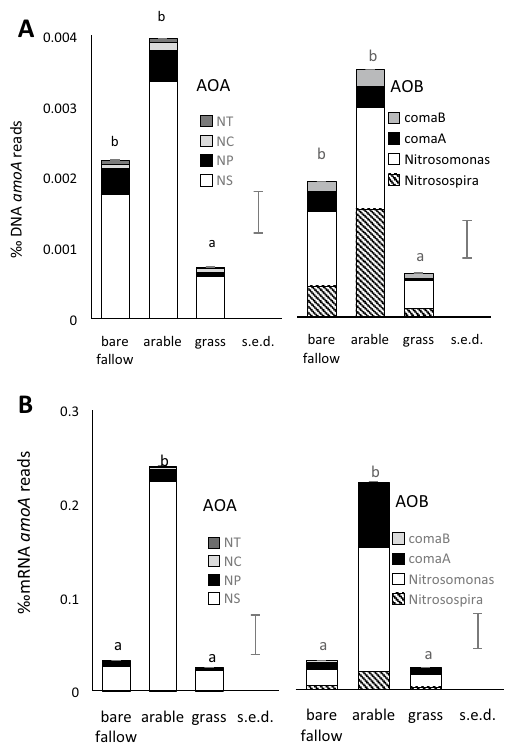
Figure 4. Mean proportion of ( A )—DNA reads and ( B )—mRNA amoA reads assigned to the AOA and AOB (including comammox). The proportion of the total formed by each sub-group identified is shown (the NS AOA could not be separated into Nitrososphaera and Ca. Nitrosocosmicus). ANOVA statistics of the component groups are shown in supplementary table